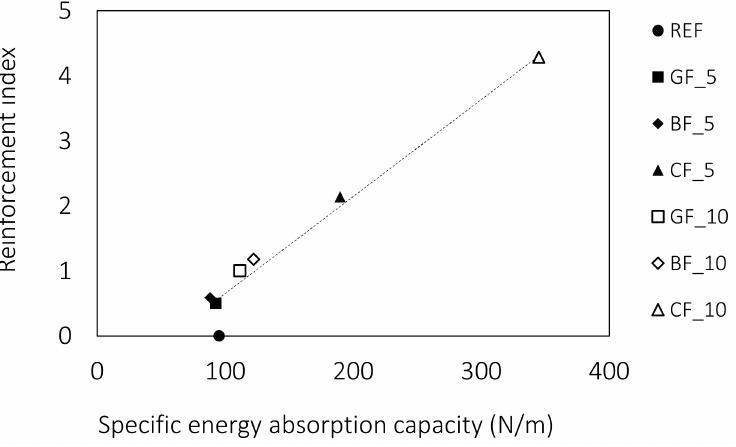
Figure 7. Correlation between the reinforcement index and specific energy absorption